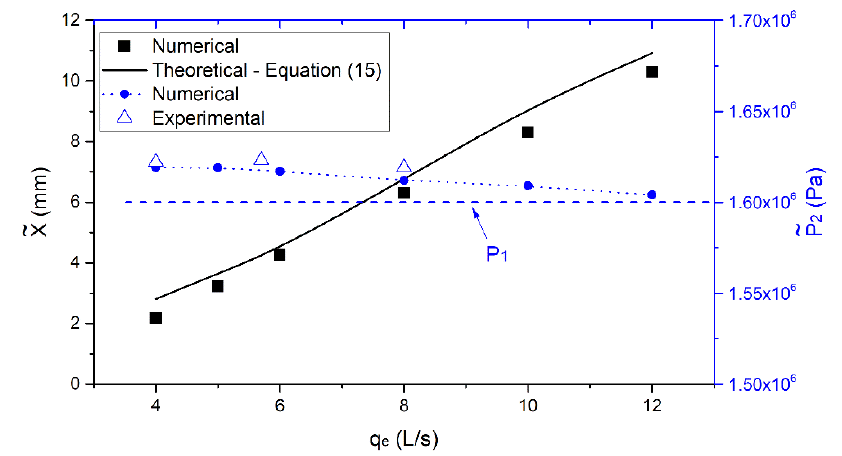
Figure 10. Variation of the equilibrium poppet displacement (cid:101) X and outlet pressure (cid:102) P 2 versus the inlet flow rate ( q e ) for P 1 = 1.6 MPa.